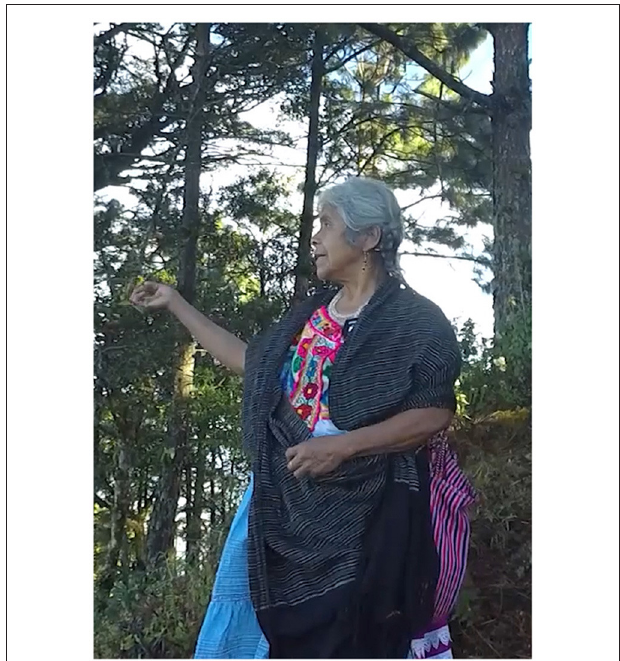
FIGURE 4 | Activity scale [target: Plain of the Spring].